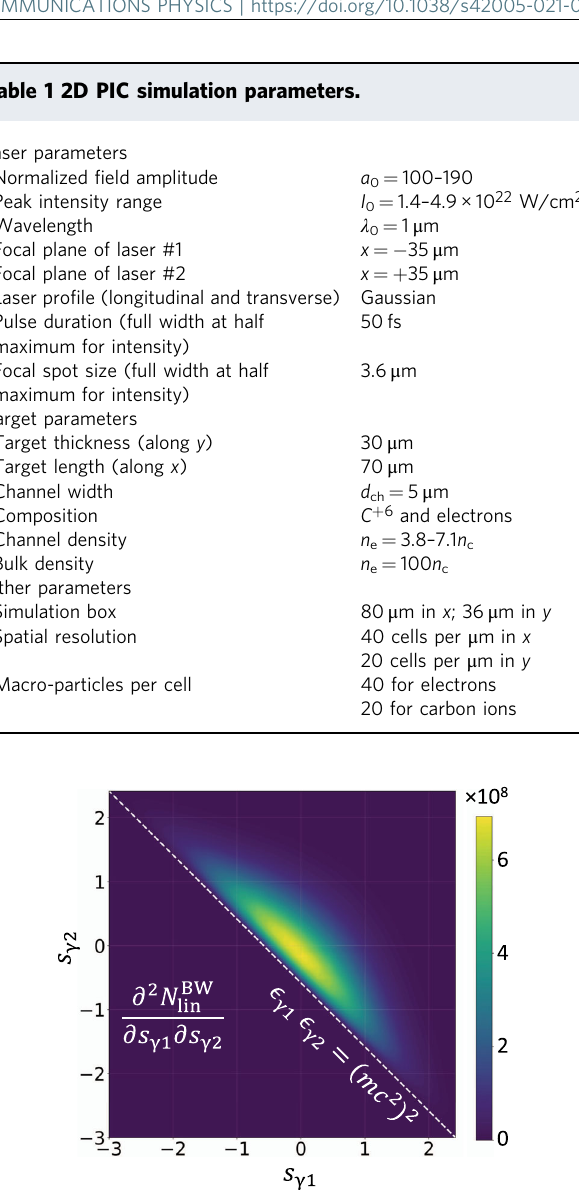
Fig. 7 Yield of the linear Breit – Wheeler process as a function of photon energies. Distribution of linear Breit – Wheeler pairs as a function of photon energies for colliding laser pulses with a 0 =